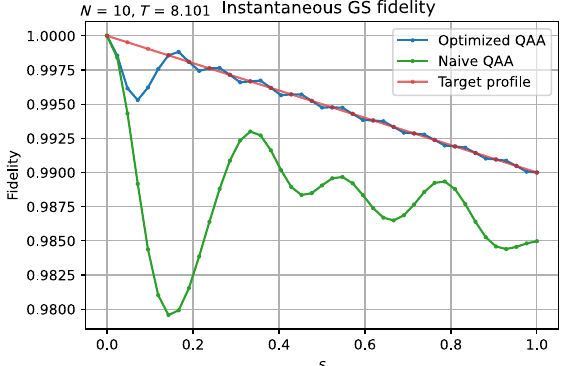
FIG. 15. The instantaneous ground-state fidelity for QAA optimized with the flexible-total-time algorithm compared to naive QAA with the same time budget. The target fidelity at s = 1 is set to θ = 0.99 and linearly interpolated along the adia- batic path. The search interval for the time spent in each chunk is upper bounded such that T i ≤ 20 ∀ i